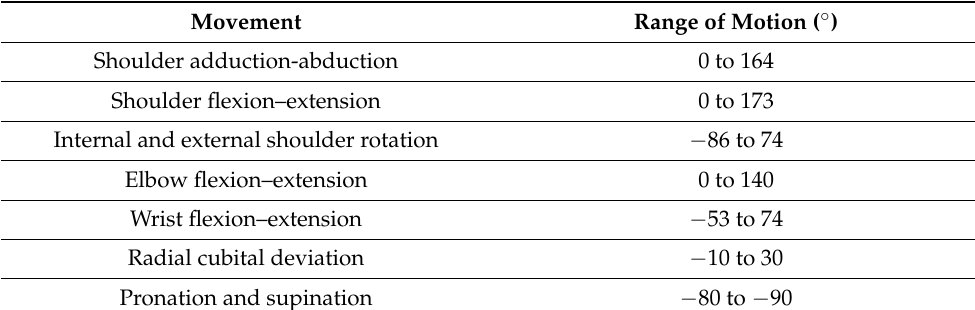
Table 1. Ranges of motion of the ERMIS exoskeleton. Movement Range of Motion (°) Shoulder adduction-abduction 0 to 164 Shoulder flexion–extension 0 to 173